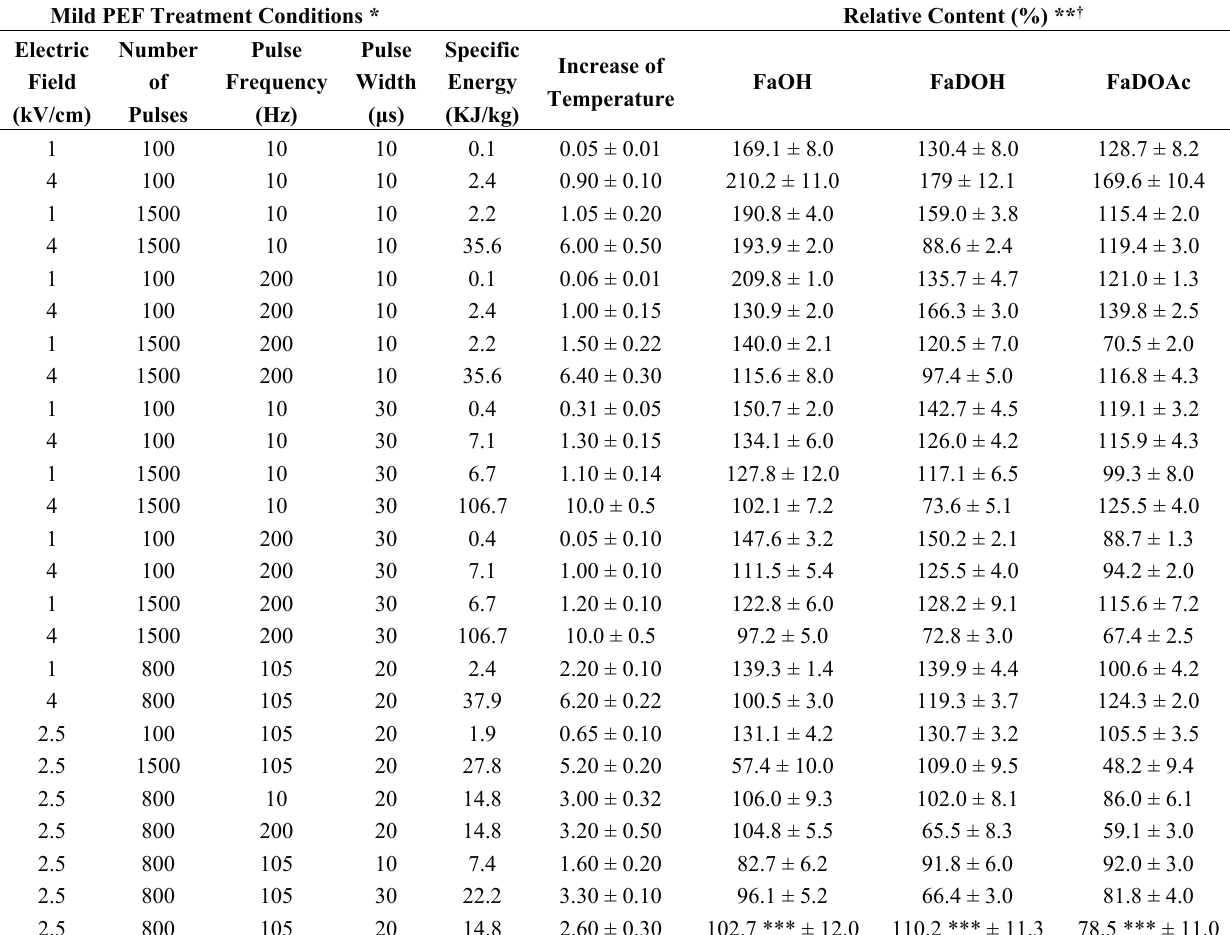
Table 1. Central composite response surface design for polyacetylenes on carrot slices treated under different mild PEF treatment